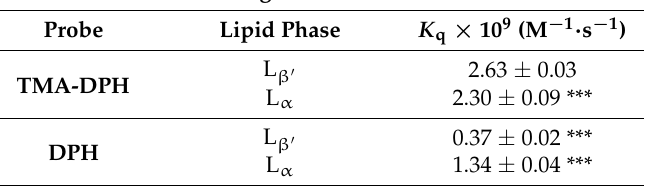
Table 2. Bimolecular quenching rate constant ( K q ) obtained from measurements of fluorescence quenching of TMA-DPH and DPH by DCF in two membrane model systems at pH 5.0 (in the case of GI mimicking) and pH 7.4 (in the case of IMM mimicking). GI mimicking: PC Membrane